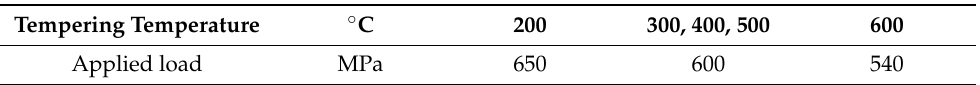
Table 2. Applied load for fatigue strength test for assumed tempering